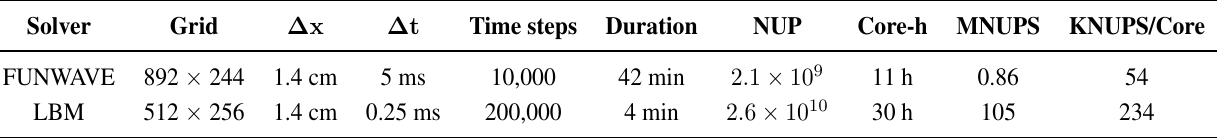
Simulation setup and performance results for FUNWAVE in comparison to NSW-LBM. Total number of node updates (NUP) and core hours (Core-h); resulting performance in million node updates per second (MNUPS) and thousand node updates per computational core